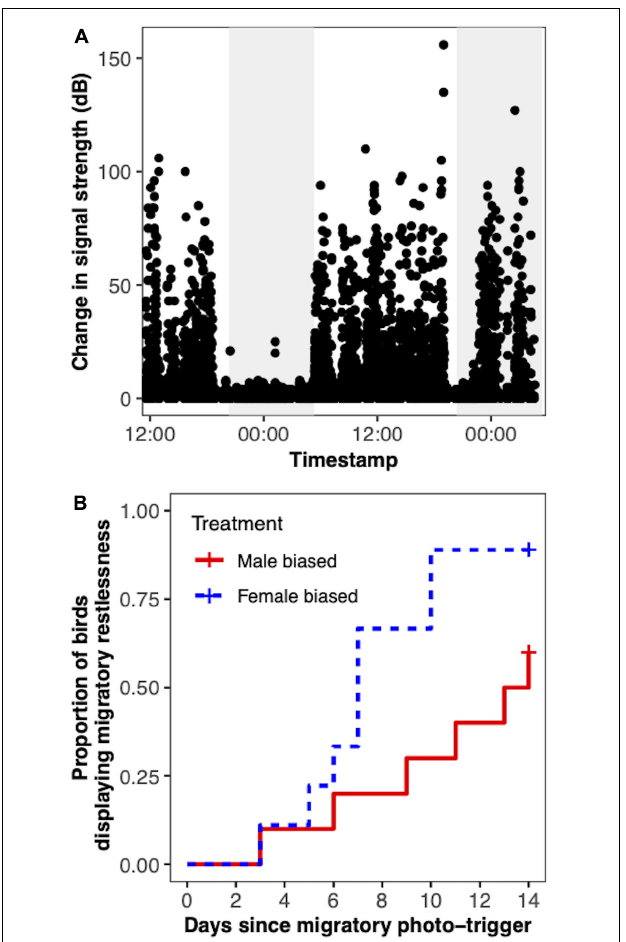
FIGURE 4 | Calculating onset of Zugunruhe in yellow-rumped warblers ( Setophaga coronata coronata ) using change in signal strength (CSS). Panel (A) demonstrates the pattern of CSS that arises in a bird that is not moving (e.g., sleeping) versus when it is moving. A higher value of CSS corresponds to more movement. The gray panel represents the night section (lights-off), and the white represents the day section (lights-on). In this example, the bird is likely sleeping during the night section labeled with a ( − ) because CSS remains low throughout the night. The bird is likely displaying migratory restlessness in the night section labeled with a (+) because CSS remains high throughout the night. Panel (B) shows the survival curve of the onset of Zugunruhe between birds exposed to a female- or male-biased social environment.